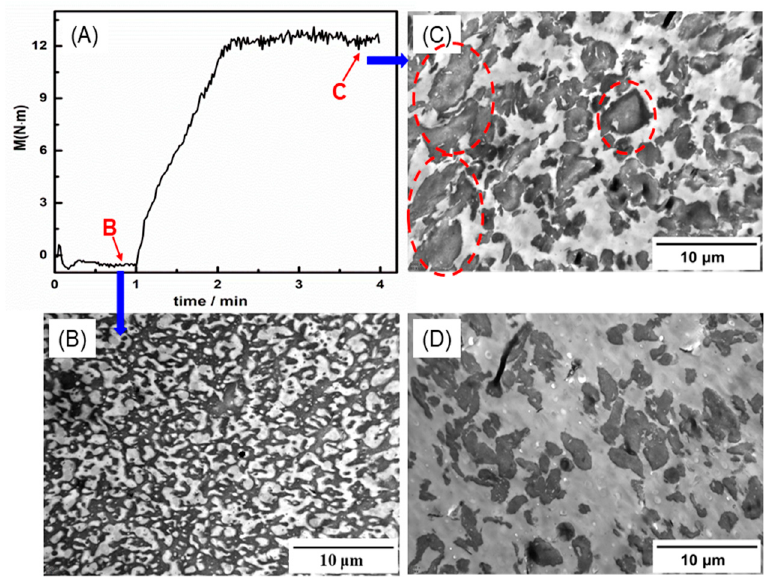
Figure 3. The relationship between different stages of polypropylene (PP)/silicone rubber (SR)-60 preparation and its morphology evolution, ( A ) Mixing torque change of PP/SR-60 preparation, ( B ) TEM image of PP/SR-60 blend at point B, ( C ) TEM image of PP/SR-60 thermoplastic vulcanizate at point C and ( D ) TEM image of PP/SR-60 TPV after hot press.